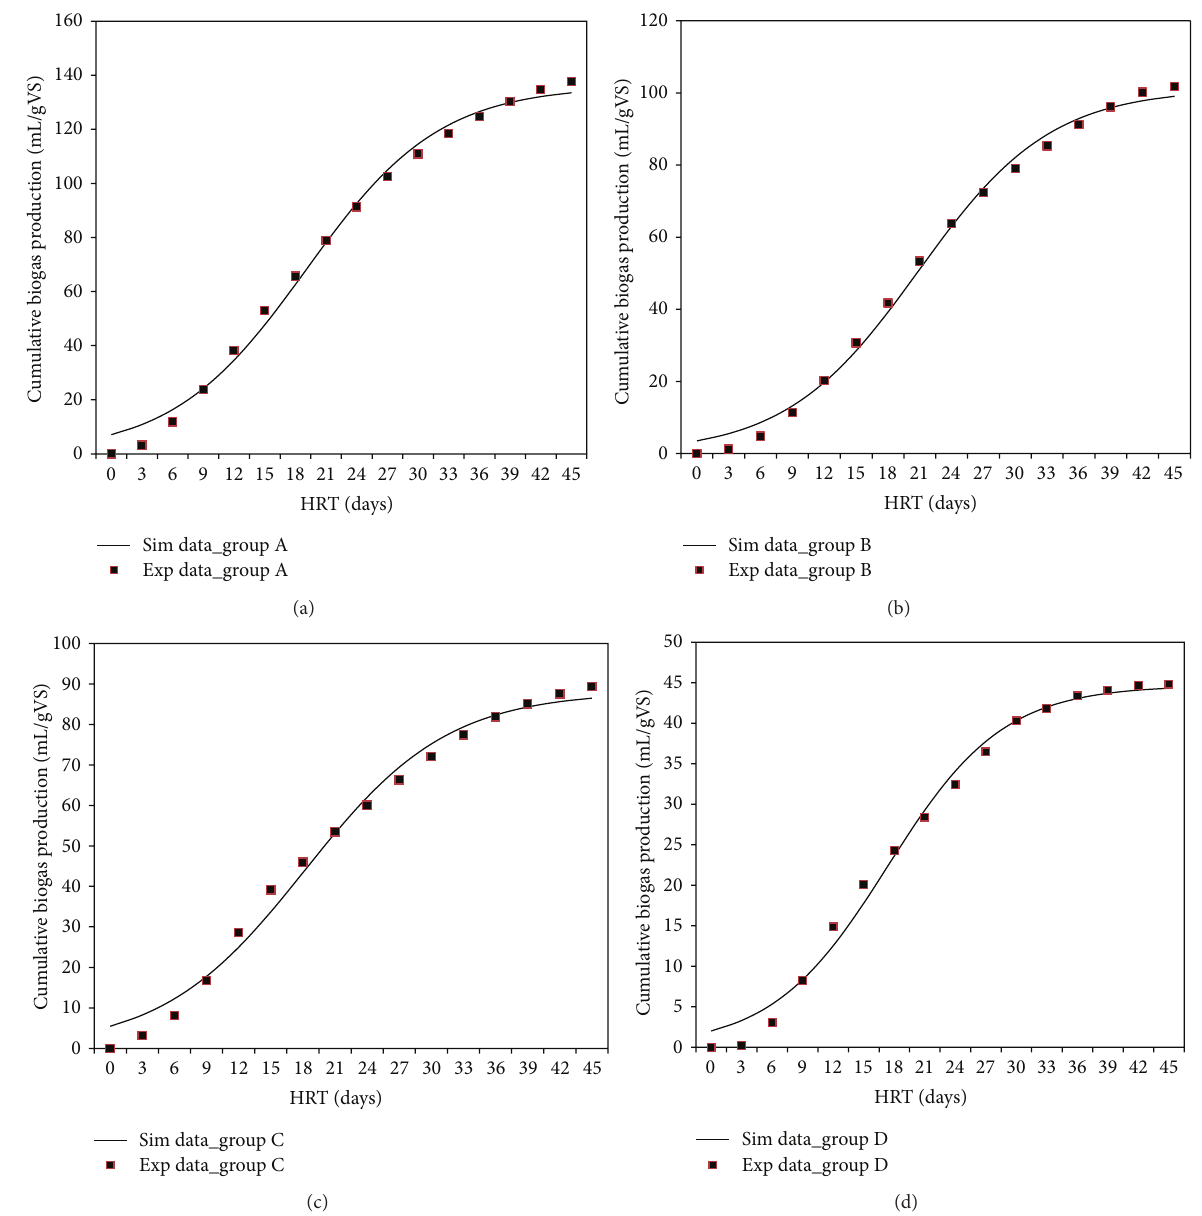
Figure 9: (a) Logistic growth model plot of cumulative biogas production for treated biomass at 135 ∘ C (group A). (b) Logistic growth model plot of cumulative biogas production for treated biomass at 85 ∘ C (group B). (c) Logistic growth model plot of cumulative biogas production for untreated biomass (group C). (d) Logistic growth model plot of cumulative biogas production for inoculum (group D).